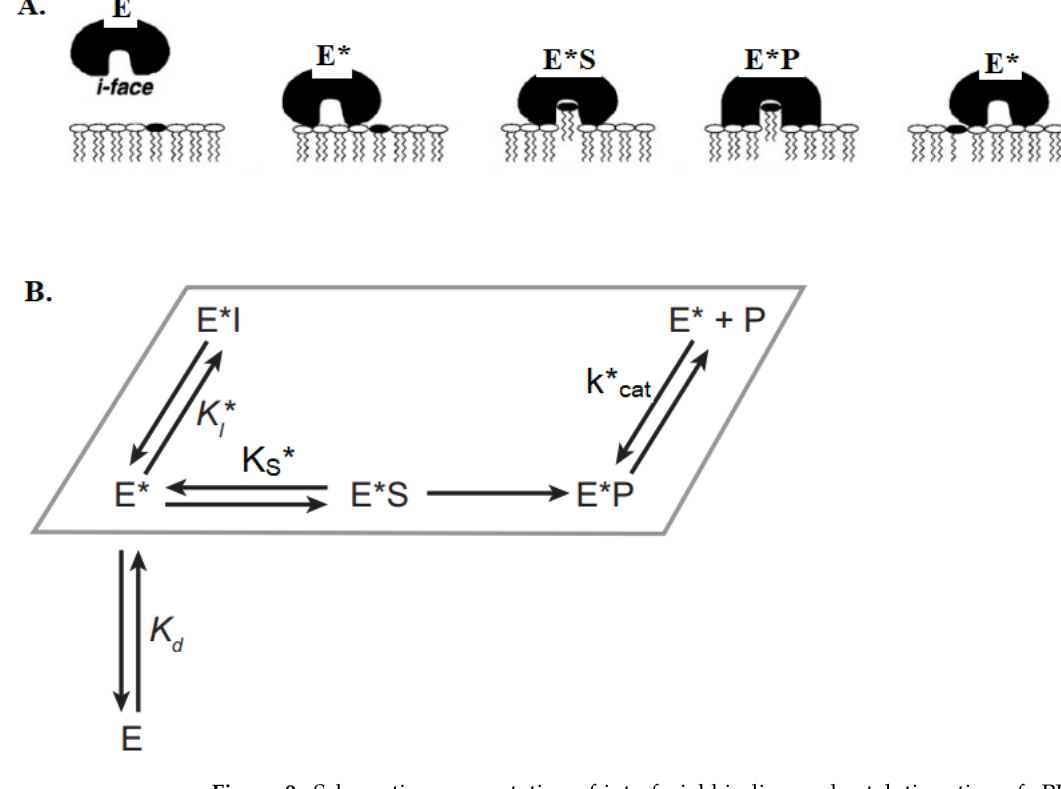
Figure 9. Schematic representation of interfacial binding and catalytic action of sPLA2. ( A ) The binding of the sPLA2 at the lipid/water interface through the i-face is essential for catalysis. The enzyme passes along the horizontal plane on the bilayer, while hydrolyzing the phospholipid molecules and releasing the LPL and FA products [20]. ( B ) The minimal kinetic scheme for the catalytic cycle of sPLA2 is shown in a parallelogram box that represents the lipid bilayer. Here, E denotes enzyme in the aqueous phase, E* denotes enzyme in a membrane-bound state without substrate and K d is the interfacial dissociation constant for the enzyme at the interface. K S , K cat and K I are the dissociation constants for substrate, product and inhibitor, respectively. E*S and E*P denote the enzyme-bound substrate and enzyme-bound product, respectively. Adapted with permission from [20]. Copyright 2001, American Chemical Society.